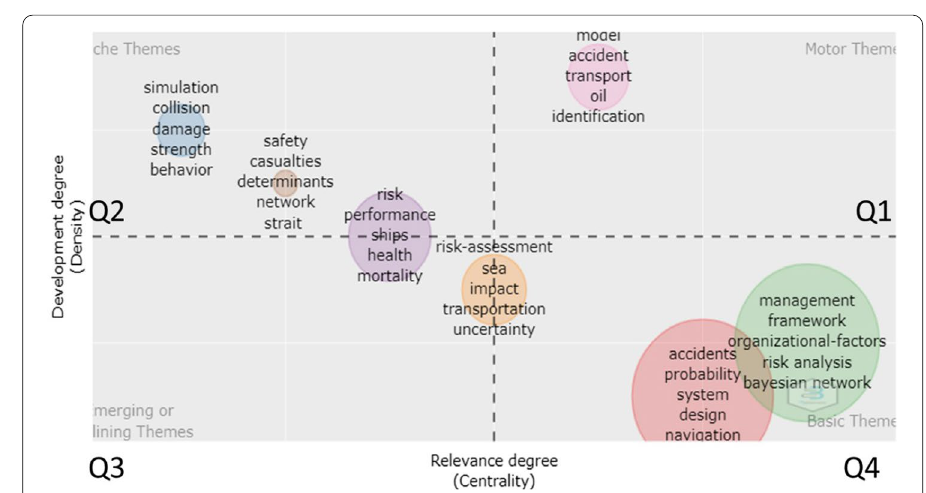
Fig. 5 Thematic map with co‑occurrence of keywords for ‘Shipping